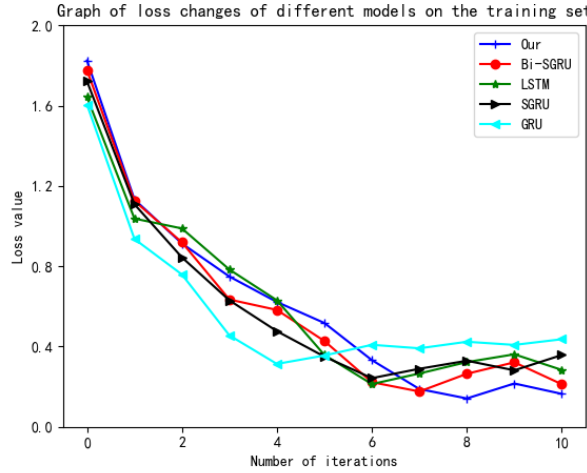
Figure 7. Loss curves of different models on the training set.